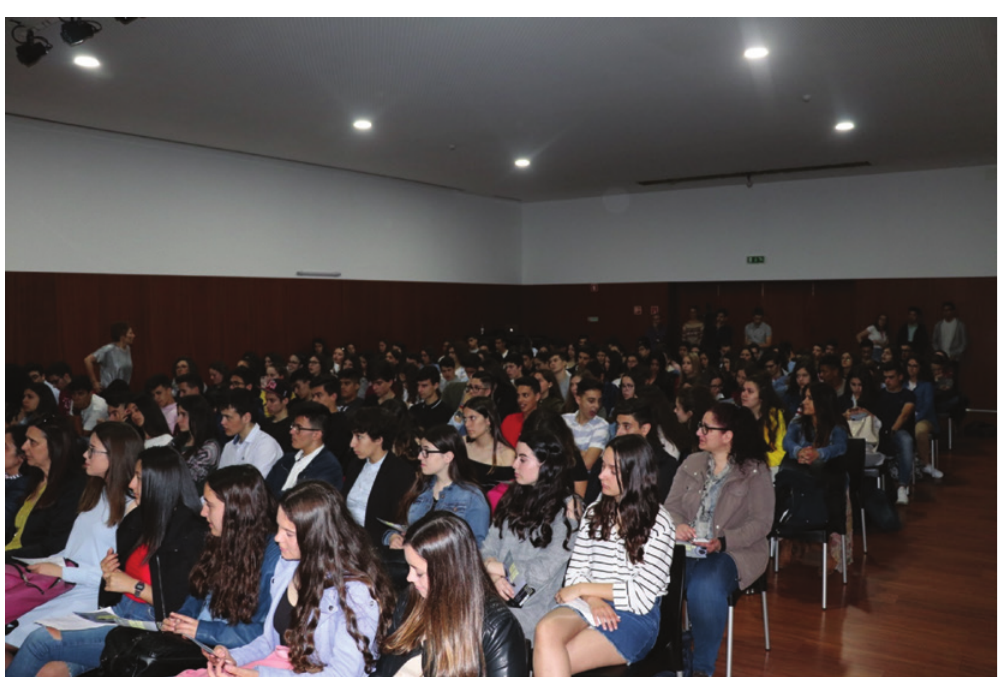
figure 6: oPl’s final presentation at the Vila Verde’s centre for arts and